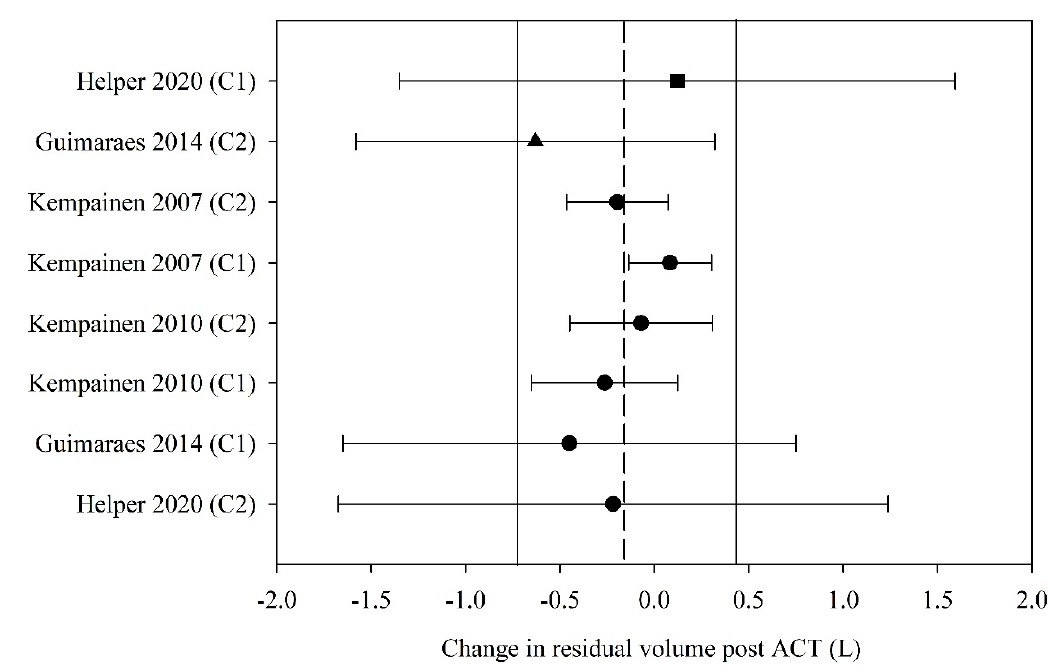
Figure 5. Pooled estimate–residual volume (litres). ACT = airway clearance techniques, C_ = crossover intervention, L = litres, (cid:4) = positive pressure device (PPD), (cid:78) = positive expiratory pressure device (PEP), • = other techniques (OT), closed symbol = stable population, dashed line = pooled estimate, solid vertical line = 95% CI, all individual data presented as mean ±